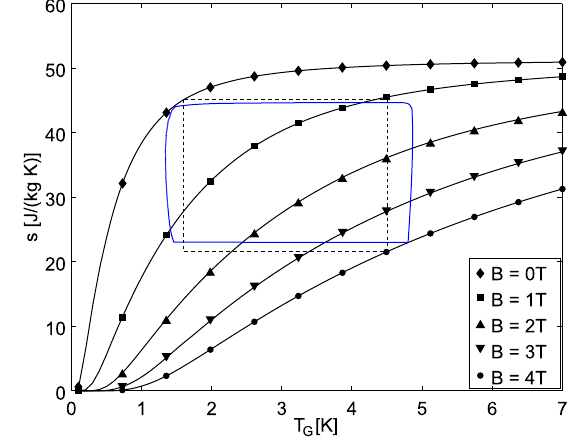
FIG. 7. Carnot cycle (dashed) and thermodynamic cycle taking into account heat exchange conditions on warm and cold sides (blue) of the designed prototype, without heat losses.